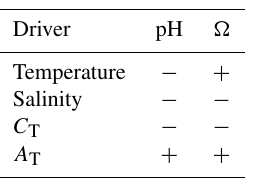
Table 1. Direction of direct effects of an increase in temperature, salinity, C T , and A T on pH and (cid:127)